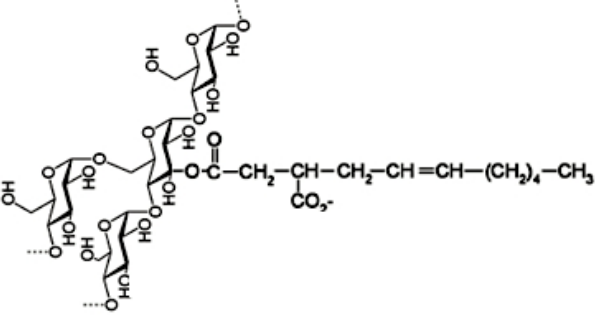
Figure 1. Chemical components of octenyl succinic anhydride (OSA) modified tapioca starch (drawn based on Reference [43]).